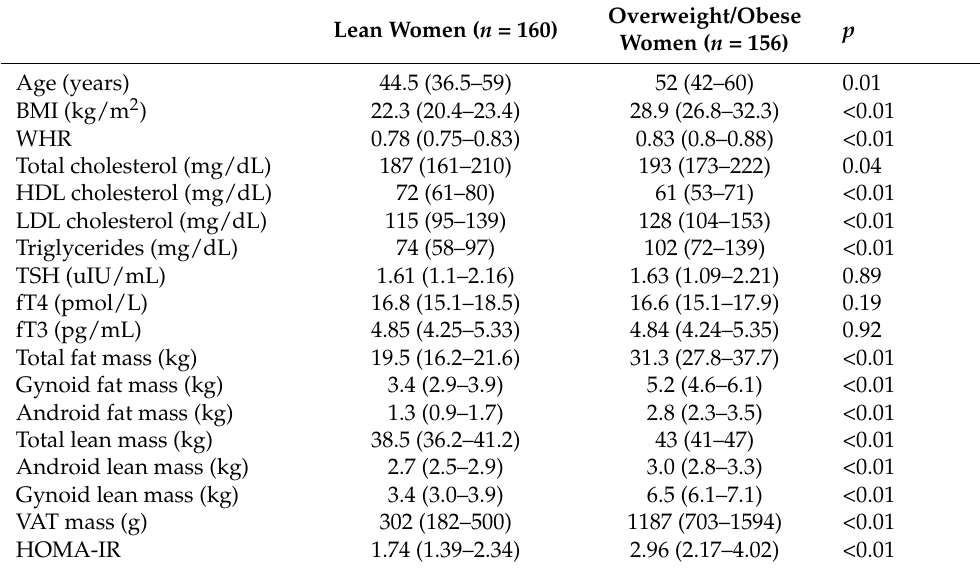
Table 1. Clinical and biochemical characteristics and body composition estimated with DXA method in lean and overweight/obese